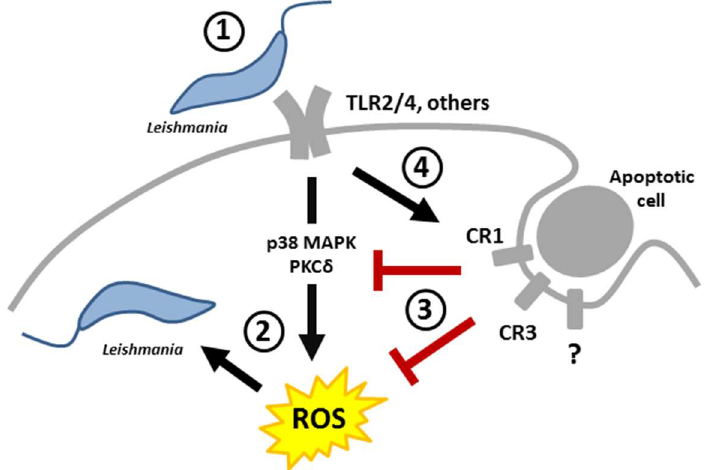
Fig 6. Apoptotic cells modulate the course of L . major infection in neutrophils. (1) Leishmania promastigotes are recognizedby neutrophils;(2) Leishmania -infectedneutrophils activate antimicrobial signaling pathways responsible for generationof ROS; (3) Signals from apoptoticcells suppress phosphorylation of pro-inflammatory kinasesand inhibit ROS production in neutrophils leadingto improved survival of the parasites; (4) Leishmania can upregulate neutrophil-mediatedphagocytosis of apoptotic cells to reducemicrobicidal environmentwithin